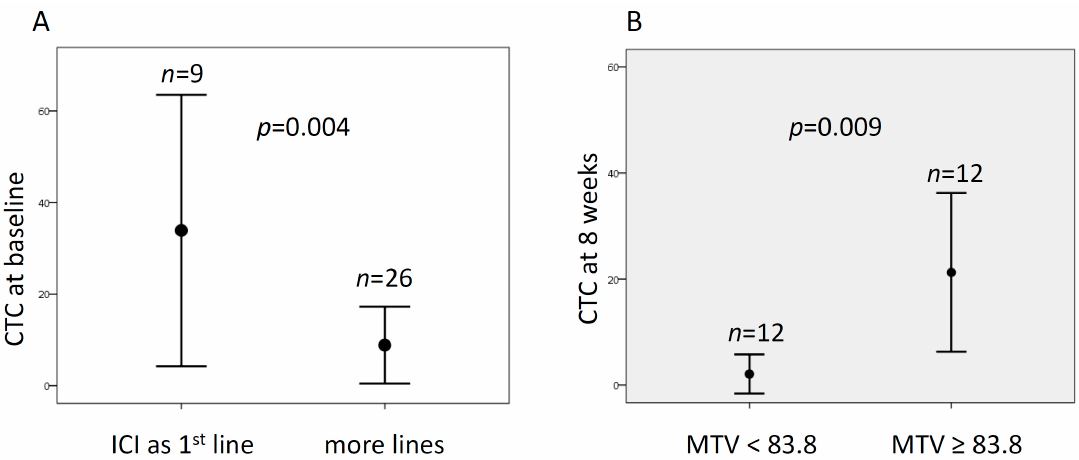
Figure 1. Association of circulating tumor cells (CTC) count with clinical-metabolic features. ( A ) Mean number of CTC at baseline according to the number of previous lines of treatment. ( B ) Mean number of CTC at the first restaging (about 8 weeks) and the median value of metabolic tumor volume (MTV).